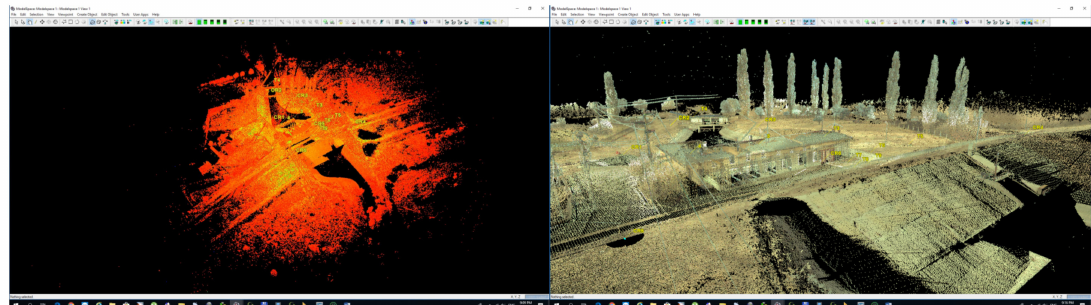
Figure 18. Point Cloud-S â nmartinu Maghiar Lock.